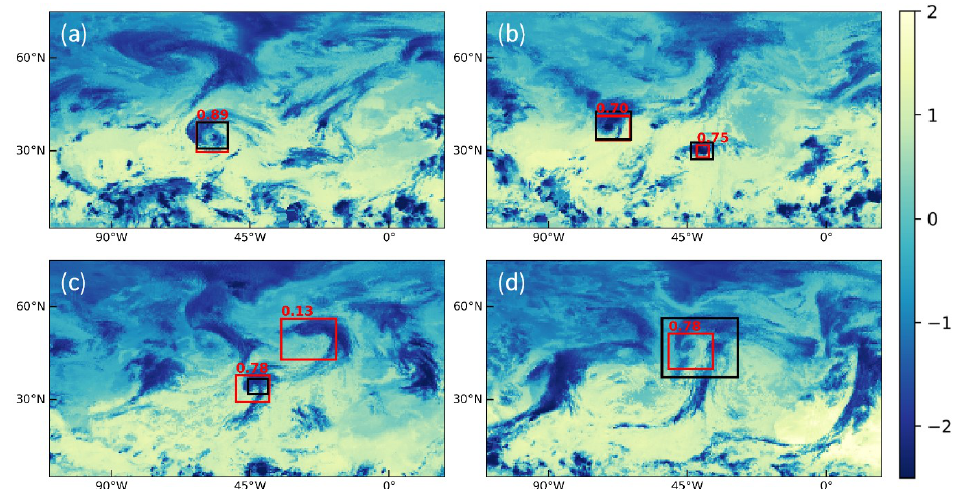
Figure 6. Examples of predictions made by the YOLOv3 in experiment A for different images/dates in the test set. ( a ) 2018/10/04 9:30 p.m. local time. ( b ) 2019/09/06 9:30 p.m. local time. ( c ) 2019/11/23 9:30 p.m. local time. ( d ) 2018/11/01 9:30 a.m. local time. Black boxes are the ground truth, while predictions and their confidence score are in red. The most sensitive “temperature” channel (wavenumber at 969.75 cm − 1 ) is shown here. Due to the normalization (described in Section 3.1), the values shown here are dimensionless.